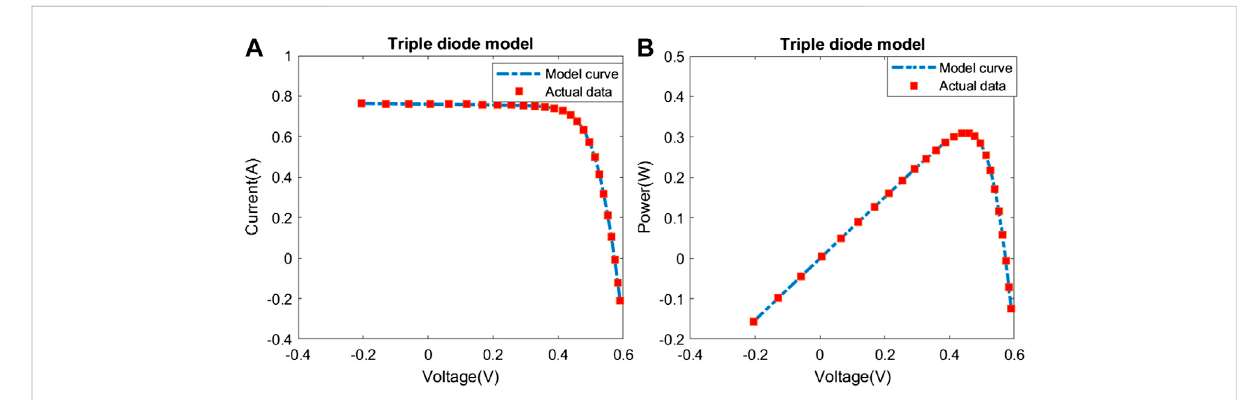
FIGURE 7 Comparison between actual data and model curve obtained by POA for TDM: (A) I-V curve and (B) P-V